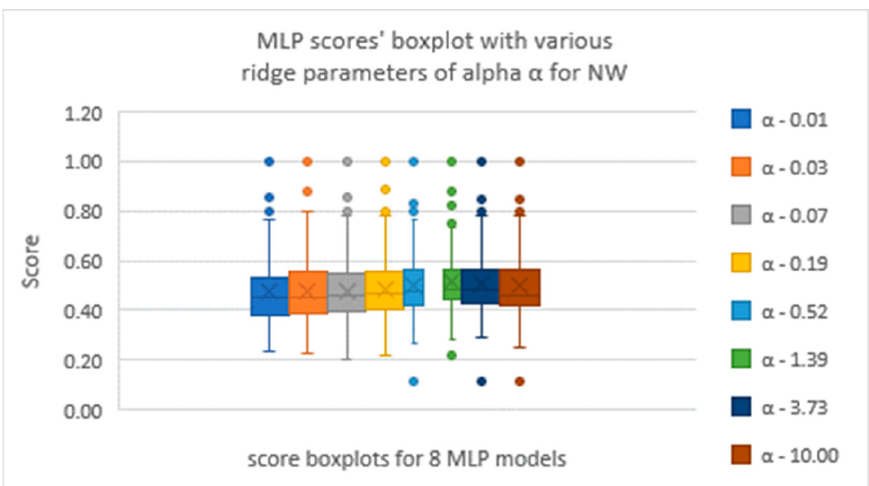
Figure 2. Box plots of results in various α on MLP performance in NW.